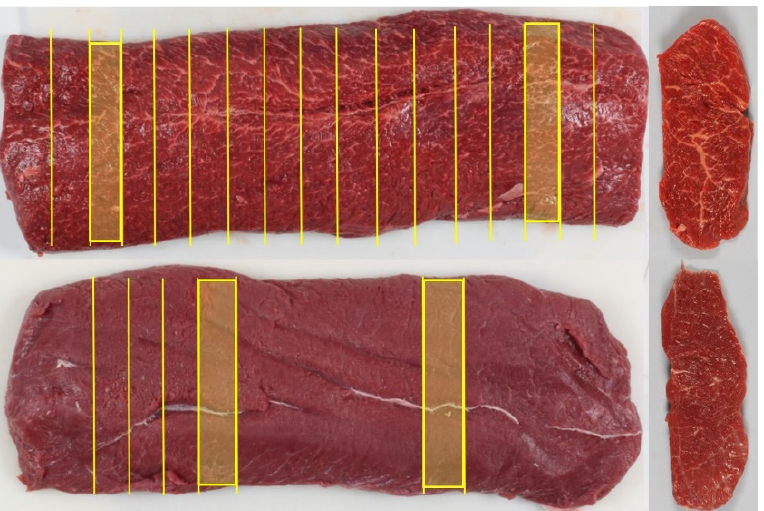
Figure 1. Two samples of whole striploins and belonging slices (right). Cutting pattern on upper loin was used for the calibration data set. Cutting pattern on lower loin was used for the test set. All cut slices were measured with NIR. Fat content was determined in shaded slices. Sensory scoring of marbling was done on all slices in calibration set and for the shaded slices in test set.